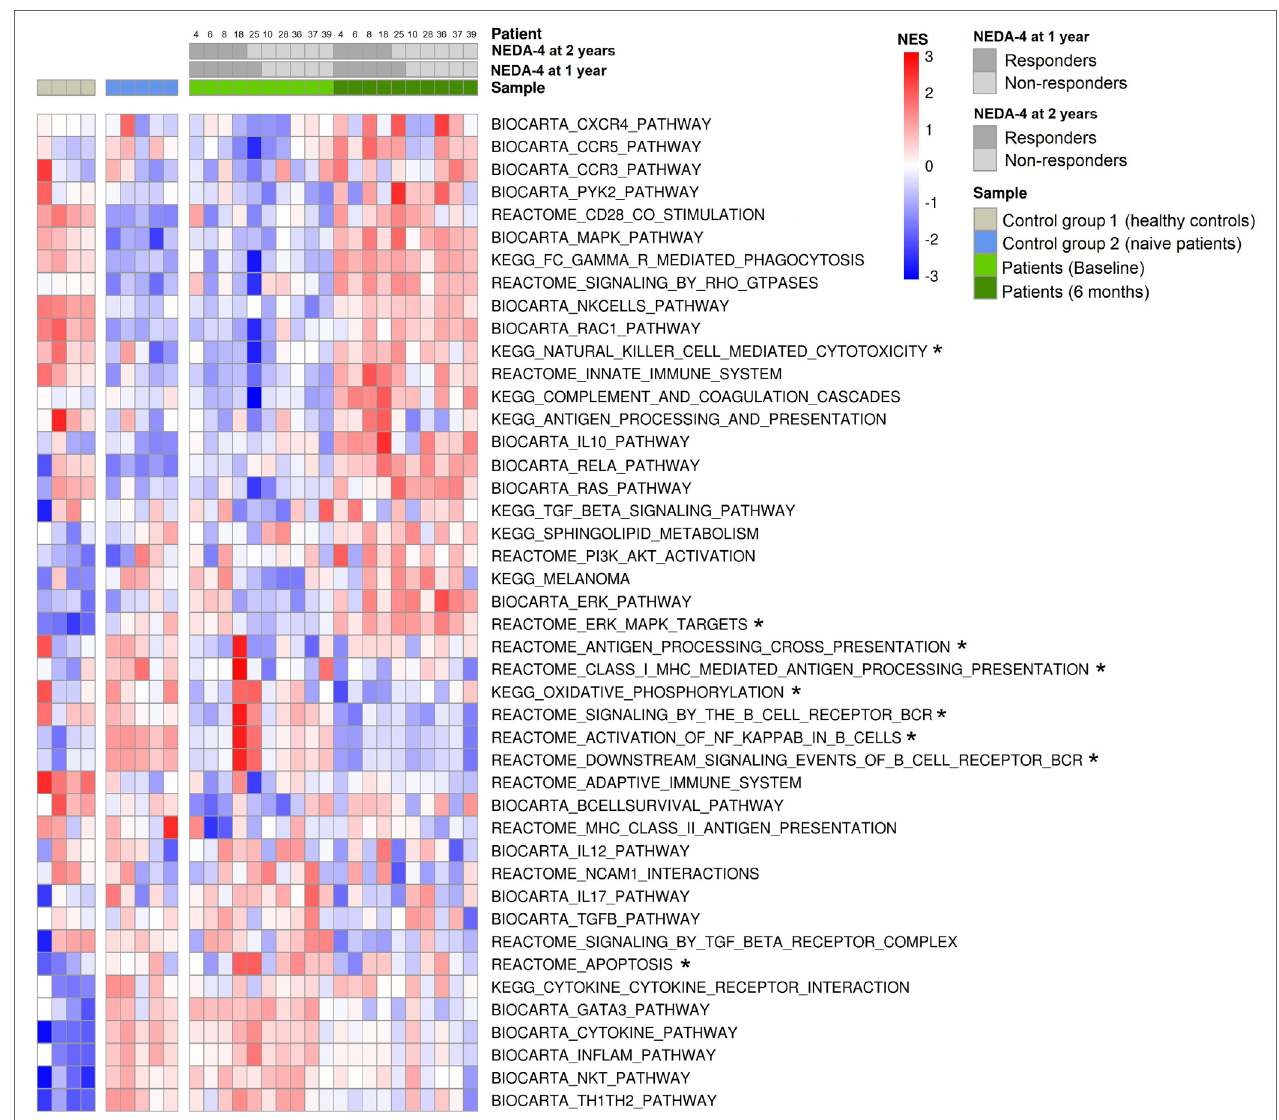
FigUre 6 | Gene set enrichment in response to fingolimod. Heatmap of significantly enriched pathways related to multiple sclerosis, autoimmunity, and fingolimod mechanisms of action that achieved significant enrichment in gene set enrichment analysis (GSEA) [false discovery rate (FDR) q -values < 0.25]. GSEA was performed using GSEA software v2.2.1 obtained from the Broad Institute, and the molecular signature database of gene sets used were Biocarta, KEGG, and Reactome. Normalized enrichment scores (NES) are indicated by the color scale, with red representing positive enrichment and blue indicating negative enrichment compared with the median NES for each pathway across all donors. Color key annotation indicating the source of each sample (healthy controls, naïve patients, patients at baseline, and patients at 6 months of fingolimod treatment) and NEDA-4 status at 1 and 2 years (responder: NEDA-4, non-responder: EDA-4) for the 10 patients (4, 6, 8, 18, 25, 10, 28, 36, 37, and 39). *Gene sets enriched before treatment only in responder patients at 1 and 2